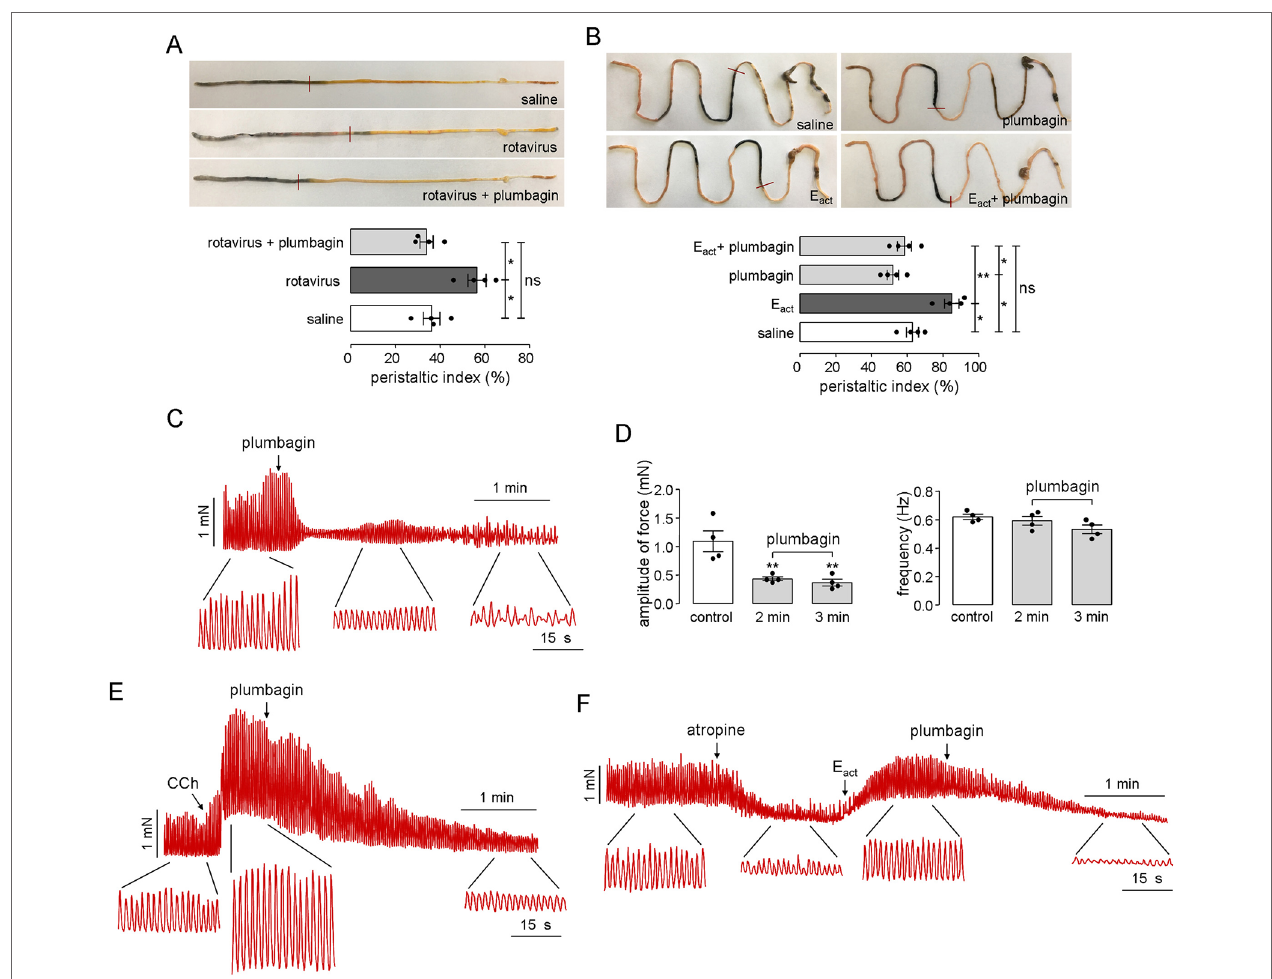
FIGURE 6 | Inhibitory effects of plumbagin on intestinal motility and smooth muscle contraction. (A) Photographs of isolated neonatal mouse intestinal tracts showing the distances traveled by activated charcoal on day 2 after rotavirus infection and gavages of saline and plumbagin (20 µM). The bar graph shows the peristaltic indexes of activated carbon in the intestines (four mice per group, *p < 0.05). (B) Photographs of isolated mouse intestinal tracts showing the distances traveled by activated charcoal after the administration of saline and plumbagin (20 µM) by oral gavage and E act (50 µM) by intraperitoneal injection. Peristaltic indexes of activated carbon in the intestines are shown in the bar graph (four mice per group, *p < 0.05, **p < 0.01 and ns, no significant difference). (C) Representative traces from mouse ileal segments showing the effects of plumbagin (20 µM) on basal contractions. (D) Plumbagin effect on the amplitude of force and contraction frequency (four ileal segments per group, **p < 0.01). (E) Representative traces from mouse ileal segments showing the effects of plumbagin (20 µM) on CCh (1 µM)-induced contractions. (F) Effects of plumbagin (20 µM) on smooth muscle contractions following atropine (1 µM) and E act (10 µM) treatment. The representative current traces shown are from one of three independent